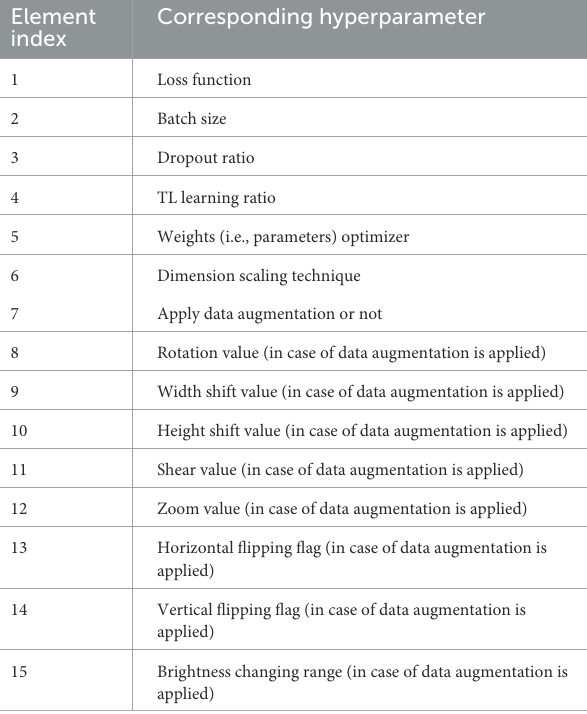
TABLE 3 Different augmentation techniques and the corresponding configurations used to balance the datasets.